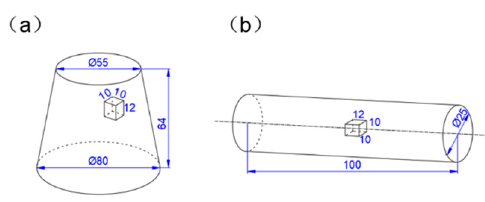
Figure 1. Sample cutting diagram ( a ) ingot; ( b ) rod.